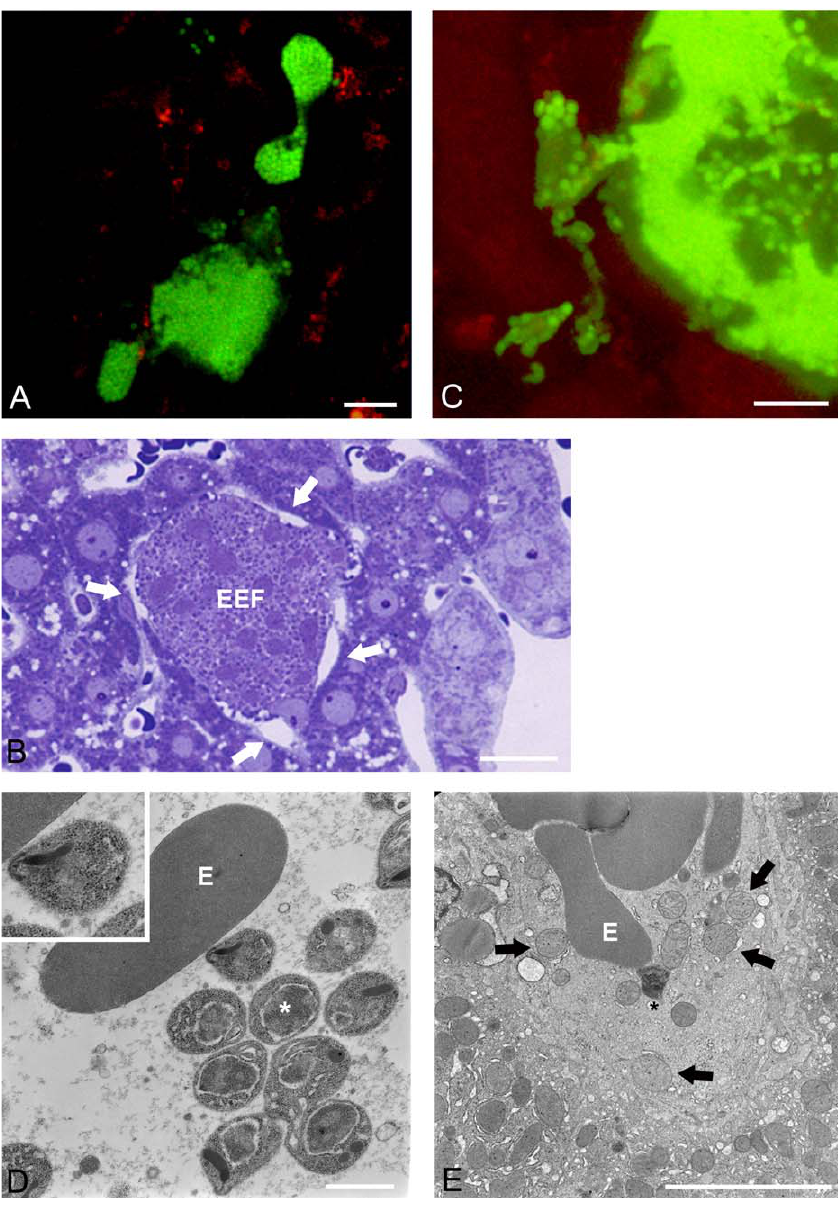
Figure 2. Merozoite Release by Merosome Formation (A) Intravital microscopy of merosomes budding from an EEF. Note that a few individual merozoites are located in the vicinity of the EEF (see Videos S1– S3). Bar ¼ 10 l m. (B) Semithin Epon section showing an EEF that has lost contact with the surrounding parenchyma (arrows). Bar ¼ 10 l m. (C) Projection of an EEF in the process of disintegration; note that the cell releases individual merozoites into the environment (see Video S4). Bar ¼ 10 l m. (D) Electron micrograph showing merozoites located free in a liver sinusoid. The apical pole of one of the merozoites is in close contact with an erythrocyte (insert). E, erythrocyte; *, merozoites. Bar ¼ 1 l m. (E) Liver sinusoid containing free hepatocyte mitochondria (arrows) and a free merozoite. E, erythrocyte; *, merozoite. Bar ¼ 5 l m.